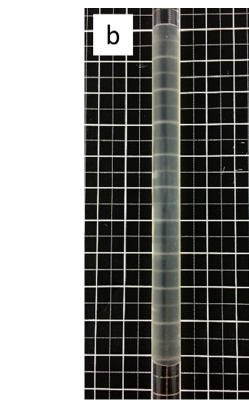
Figure 2. ( a ) Nitinol stent; ( b ) nitinol-PET stent graft; ( c ) nitinol-PU stent graft.